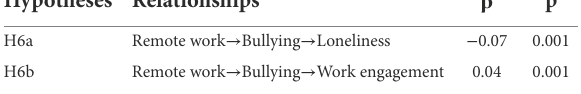
TABLE 5 Specific indirect